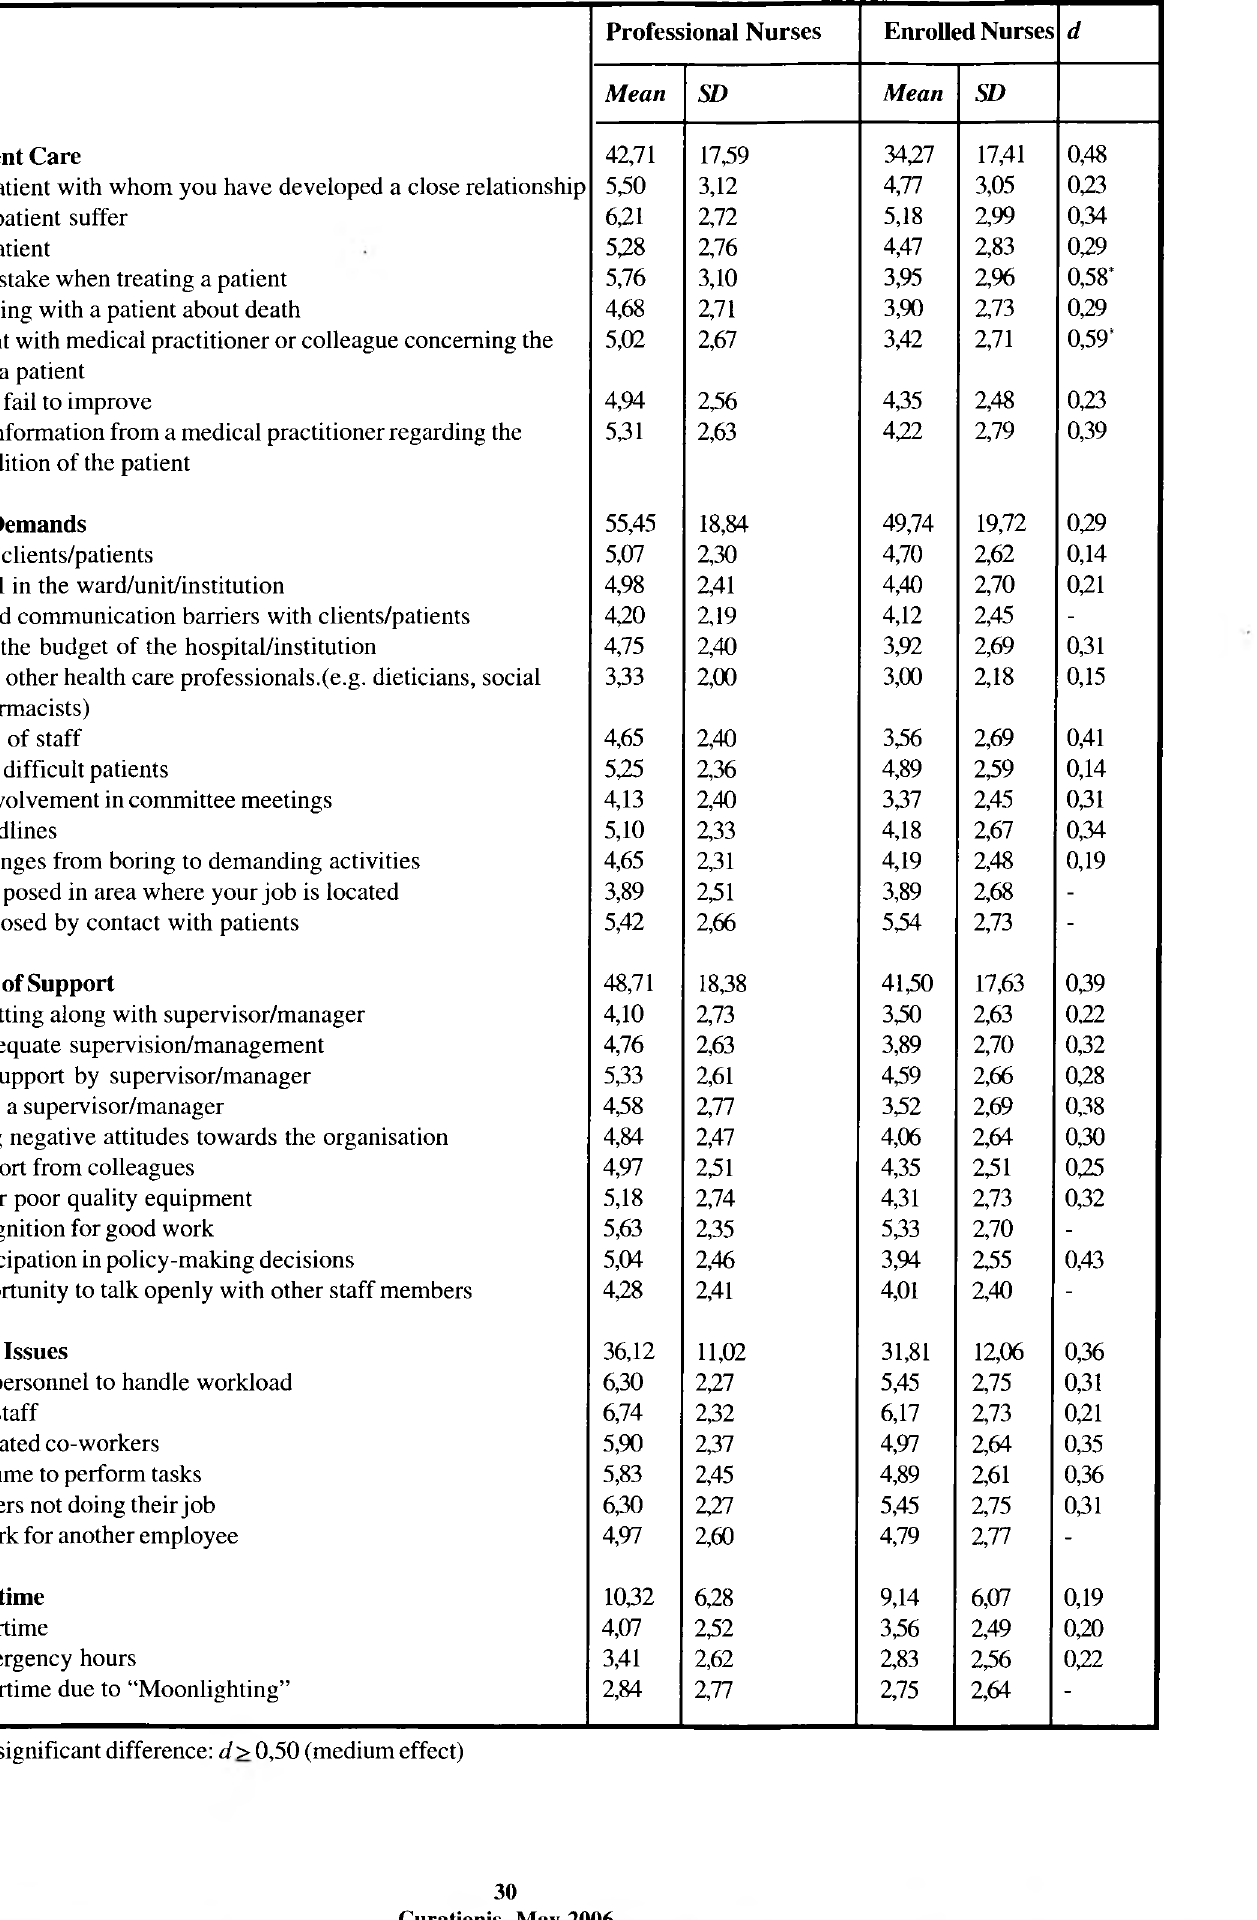
Table 5 The significance of differences between intensity of stressors for professional and enrolled nurses